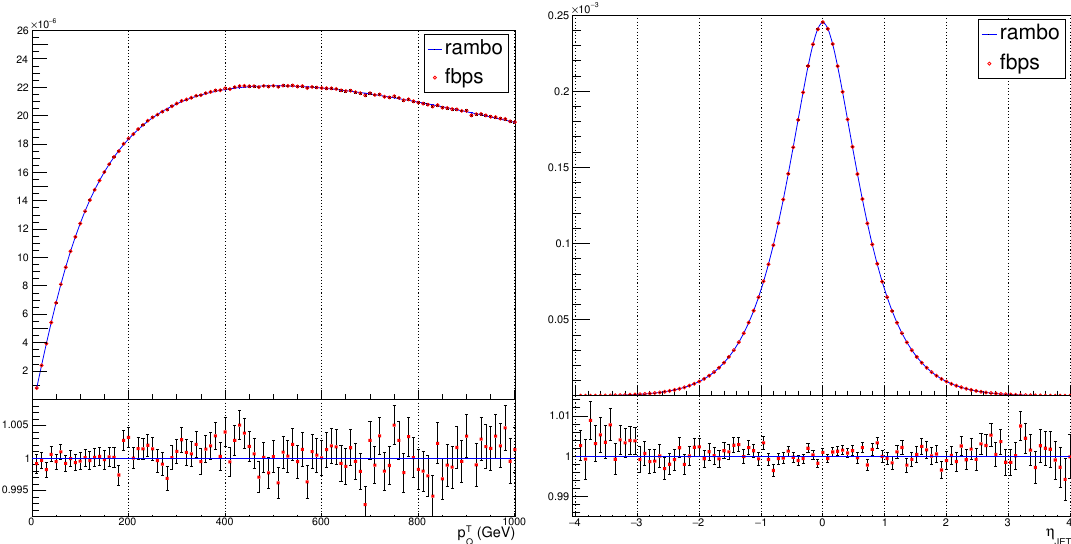
Figure 1 . A comparison between RAMBO and the FBPS generator of eq. (2.10). The left graph compares the vector boson transverse momentum, while the right graph compares the jet rapidity. For Rambo the V + 2 particle phase space was generated and a jet algorithm applied to obtain a V + 1 jet inclusive (cid:12)nal state. For the FBPS generator the observables are the Born momenta, while the phase space weight is re-weighted by the bremsstrahlung